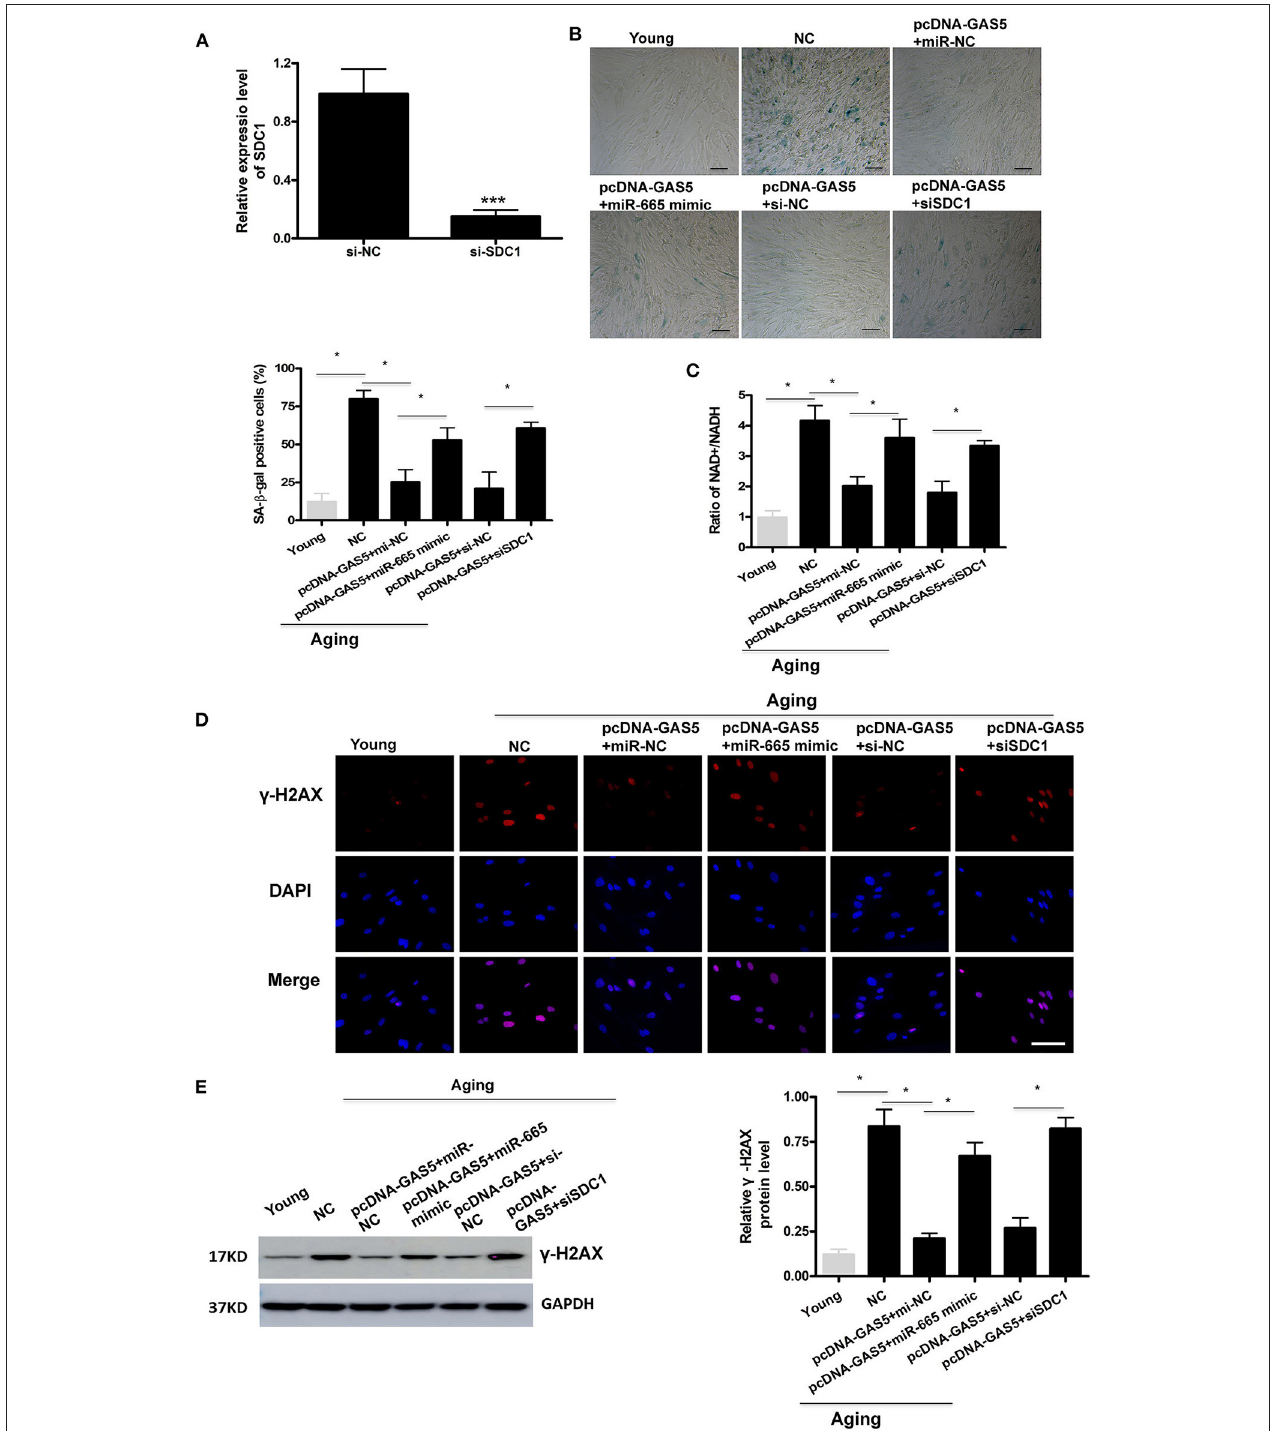
FIGURE 4 | MiR-665 interacts with lncRNA GAS5 and SDC1 to regulate VSMC senescence. (A) qRT-PCR-based evaluation of transfection efficiency of SDC1 in aging VSMCs. *** P < 0.001. (B) Representative photomicrographs and average data of SA β -gal staining in young and aging VSMCs cotransfected with pcDNA-GAS5 and miR-665 mimic/miR-NC or si-SDC1/si-NC. * P < 0.05. (C) Representative average ratio of NAD + /NADH in young and aging VSMCs cotransfected with pcDNA-GAS5 and miR-665 mimic/miR-NC or si-SDC1/si-NC. * P < 0.05. (D) Representative immunofluorescence assay of γ -H2AX in young and aging VSMCs cotransfected with pcDNA-GAS5 and miR-665 mimic/miR-NC or si-SDC1/si-NC. * P < 0.05. (E) Representative Western blot assays of γ -H2AX in young and aging VSMCs cotransfected with pcDNA-GAS5 and miR-665 mimic/miR-NC or si-SDC1/si-NC. * P < 0.05.